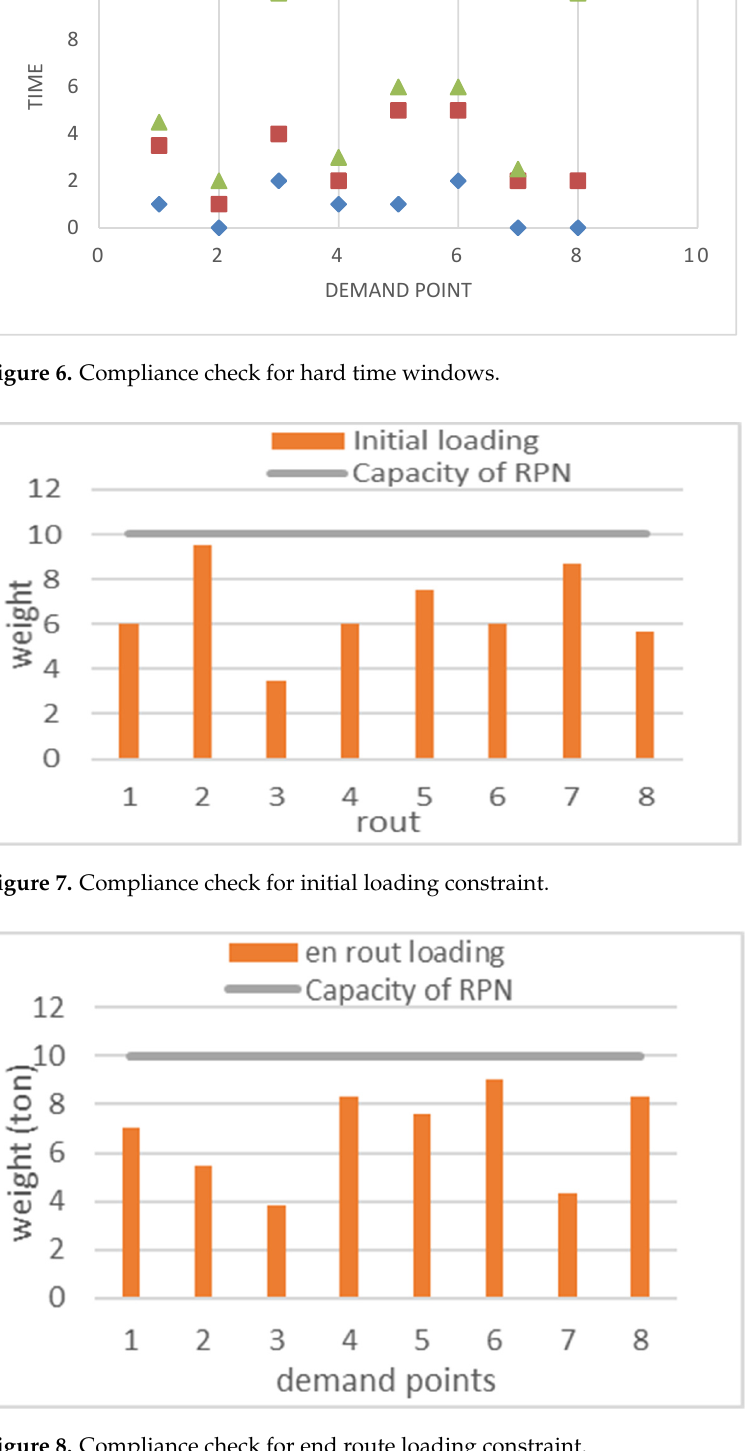
Figure 8. Compliance check for end route loading constraint.